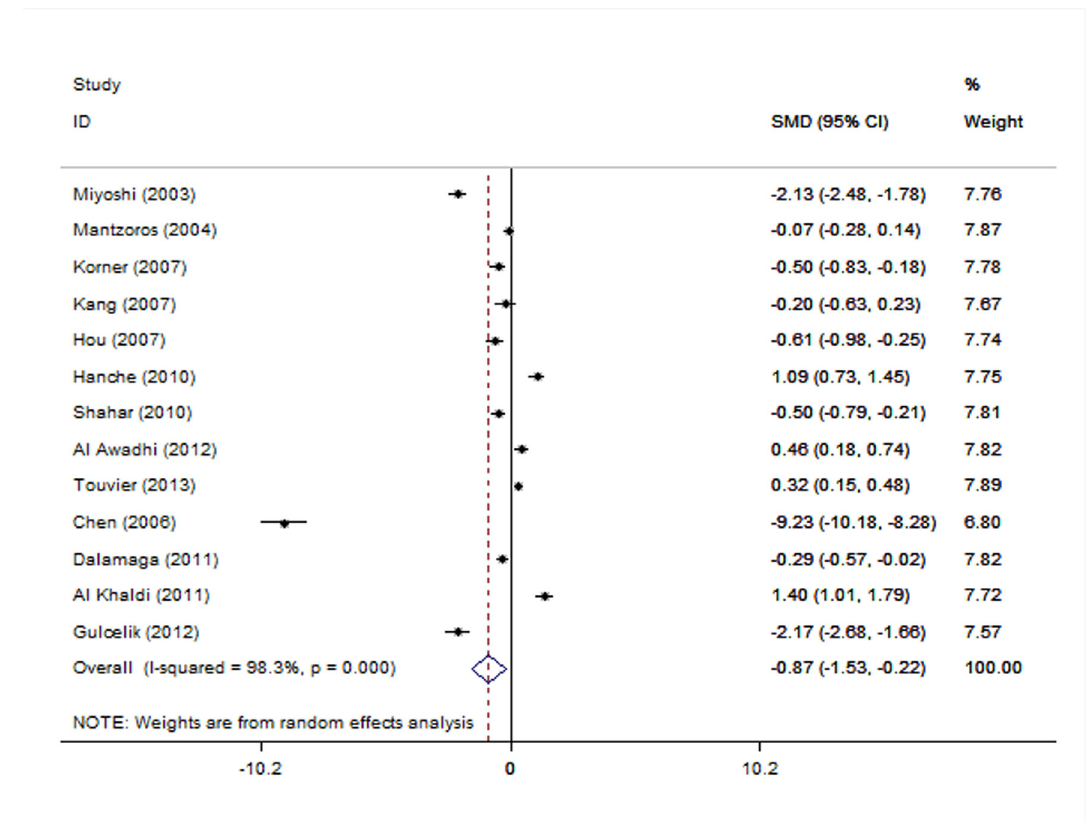
Figure 7. The effect of adiponectin on breast cancer